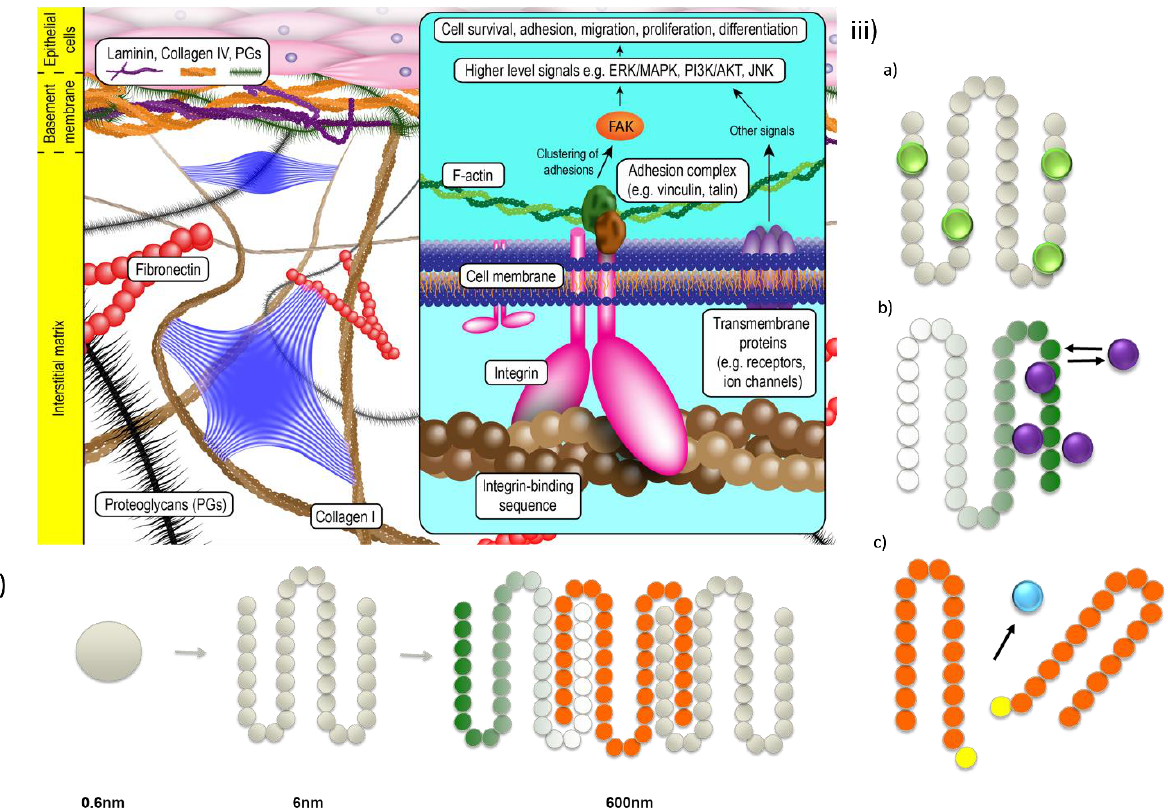
Figure 1. Self-assembling peptides as mimics for the natural cellular environment. ( i ) Cells exist within the extracellular matrix, an information-rich support scaffold. Key to this activity is the formation of recognition sites between the cells and peptide sequences within the fibrous structures and proteins of the Extracellular Matrix (ECM). ( ii ) Self-assembling peptide structures are excellent synthetic analogues for the ECM. Simple subunits are synthetically coupled to yield chains, which then interact with self-recognition to form structures of similar length scales to the ECM; with careful design, these SAPs can also present the integrins required by nature and include regions that bind and release drugs and bioactive molecules. ( iii ) Drugs can be incorporated to and be delivered from these SAPs by adding functionality to the amino acid sequence, such as ( a ) covalent (permanent) presentation, ( b ) electrostatic (reversible) attraction or ( c ) biocatalytic